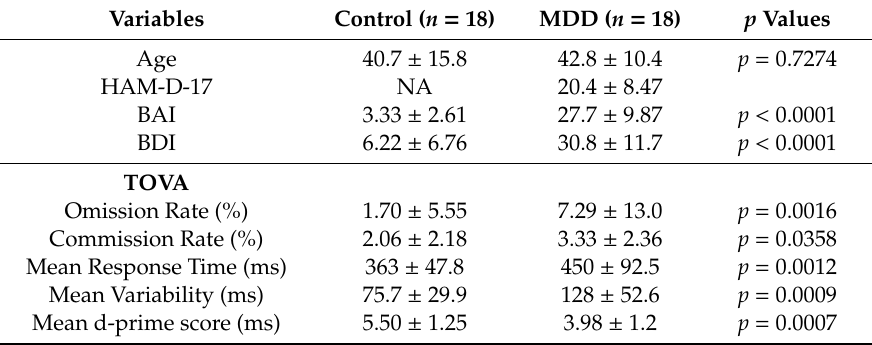
Table 2. Demographic data, TOVA, theta cordance, and ApEn of the MDD and control